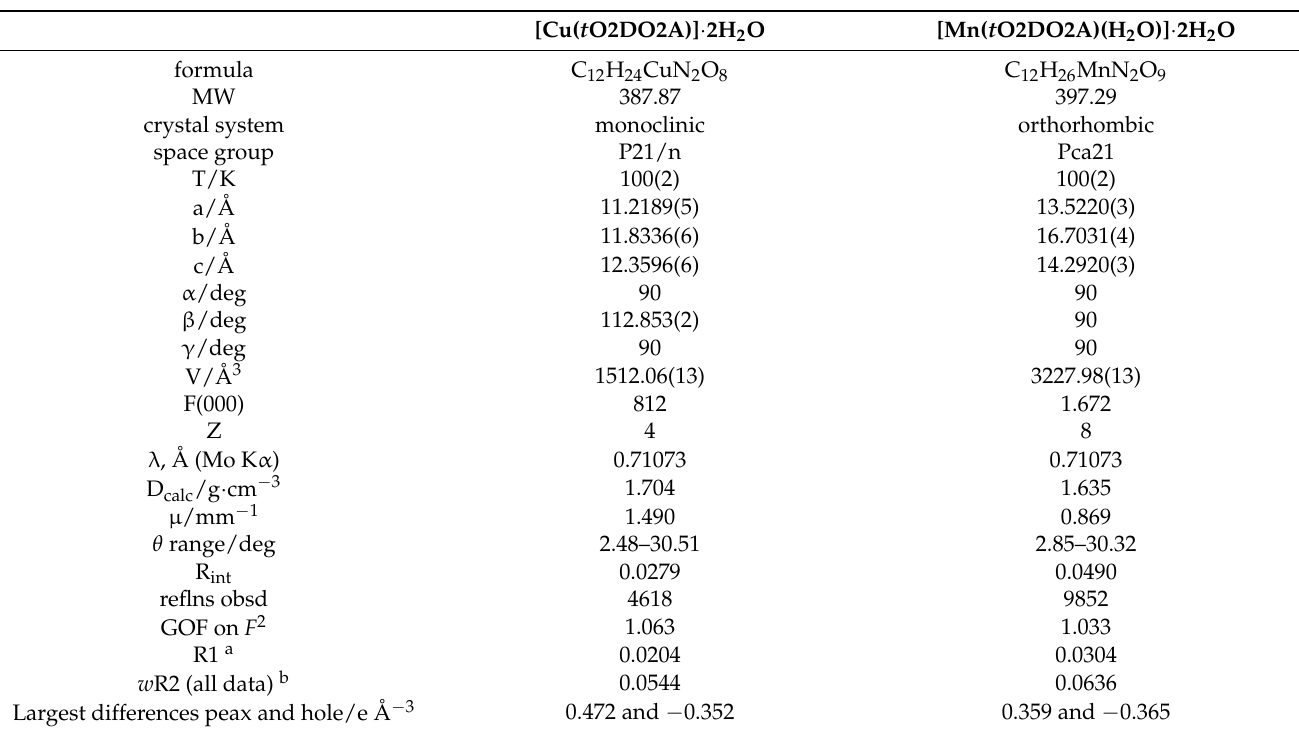
Table 6. Crystal data and refinement